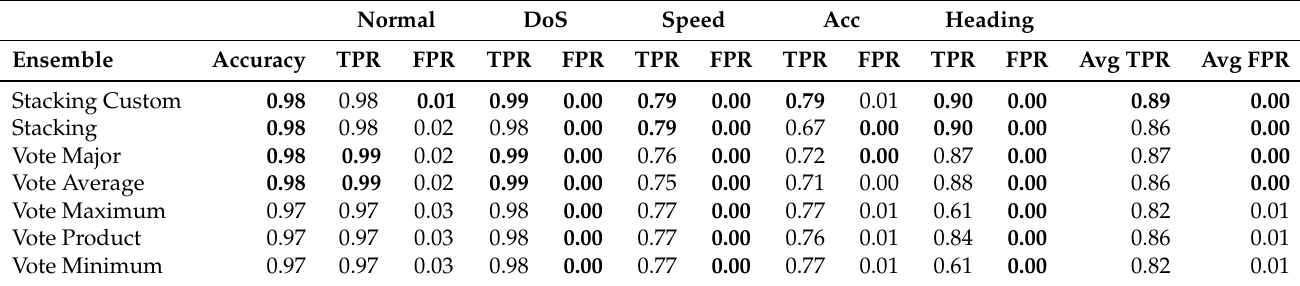
Table 8. Results for the classification using Ensemble